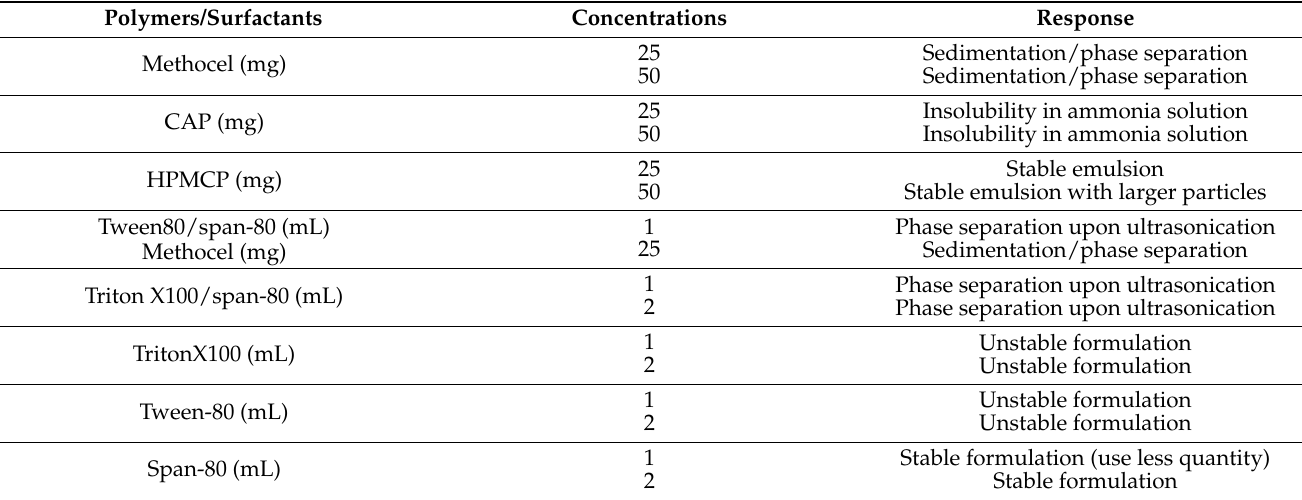
Table 1. Optimization of formulation based on polymers and